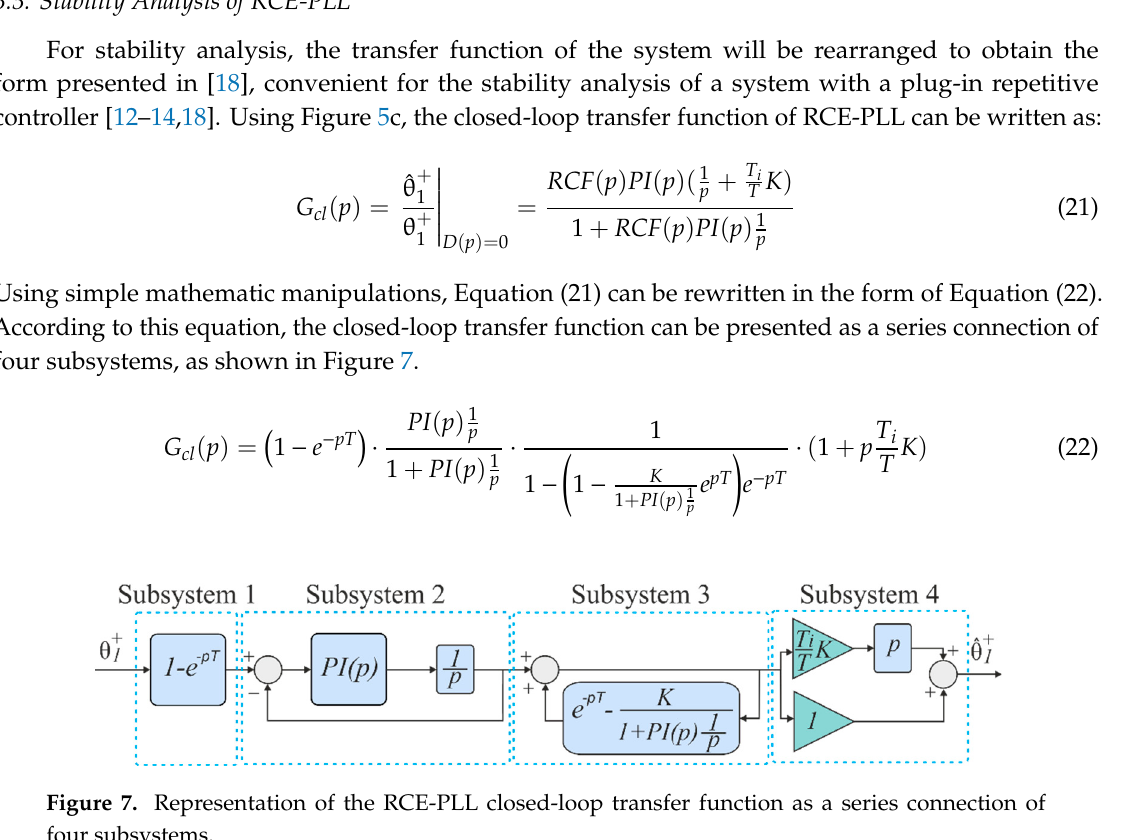
11 of 26 Figure 6. Dynamic behavior of RCE-PLL and its small-signal model. ( a ) Estimated frequency; ( b ) fundamental grid voltage vector phase angle error; ( c ) error signal before and after the RCF. Using Figure 6, two fundamental roles of online compensation block can be observed. First, from Figure 6b, it can be seen that although the phase jump in 0.1 s is 30°, at that moment, a phase angle error signal of around 20° can be observed. The RCF can immediately pass part of the step-change signal from the input to the output. Through the proportional term of the PI controller and the online compensation term, this step change of the output of RCF can be immediately transferred to the